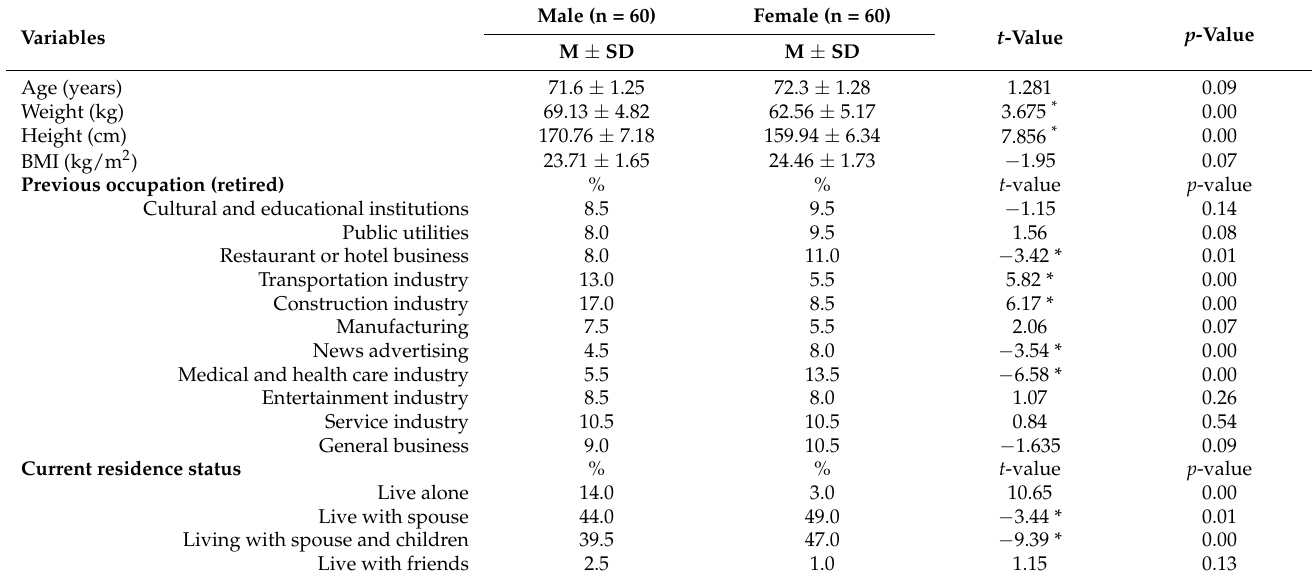
Table 2. Sociodemographic characteristics of the sample.